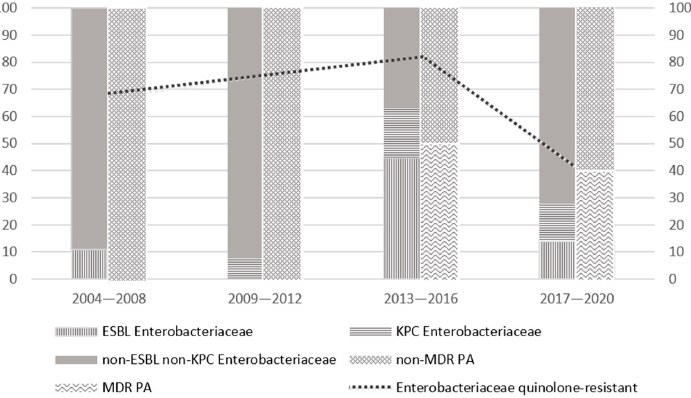
Figure 4. Susceptibility patterns of main GNB isolates on blood cultures and their evolution over time, in particular for Enterobacteriaceae (ESBL, KPC, non-ESBL non-KPC) and Pseudomonas Aeruginosa (MDR and non-MDR), as explicated by the legend below.